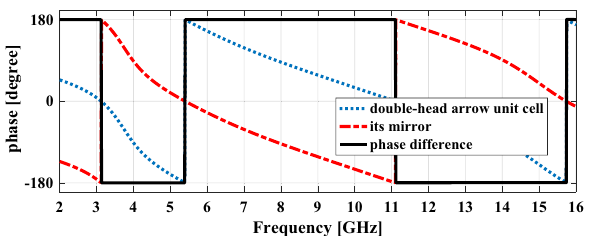
Figure 5. The phase of cross-polarization reflection for unit cell in Fig. 2 and its mirror and the phase difference between them.